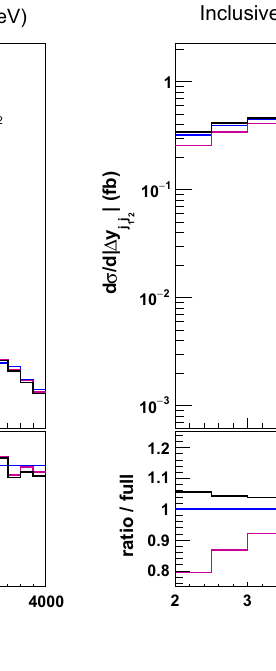
squared amplitudes are computed as | A | 2 ∼ | t | 2 + | u | 2 (left) and | A | 2 ∼ | s | 2 +| t | 2 +| u | 2 (right). In addition to the cuts of Sect. 3.3, the VBS cuts take the values m jj > 200GeV and | Δ y jj | >